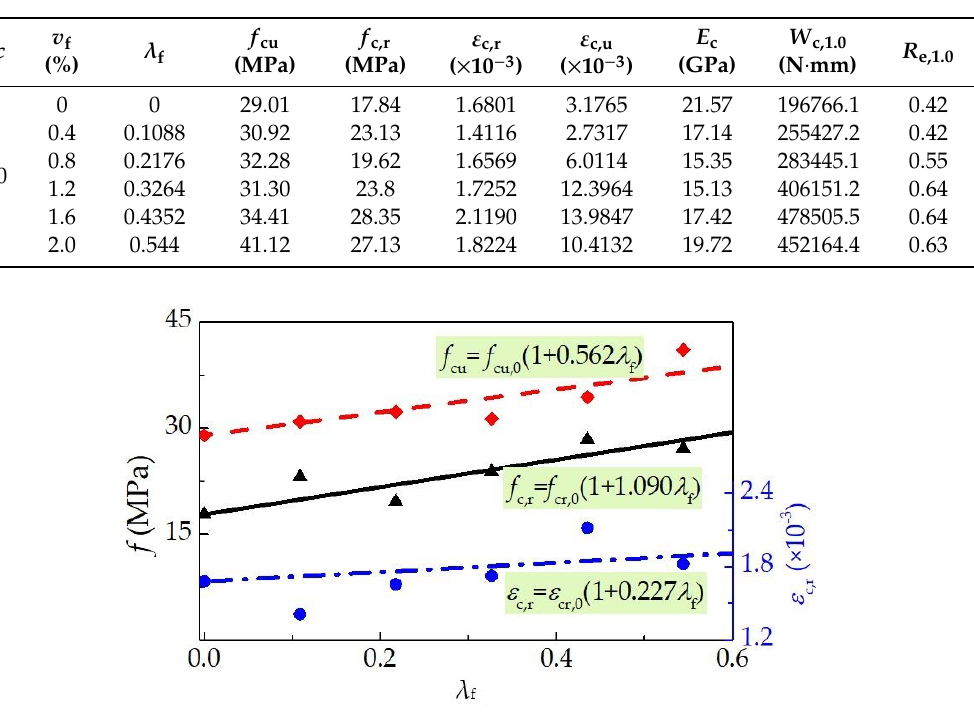
Table 4. Test result of compressive strength and toughness.